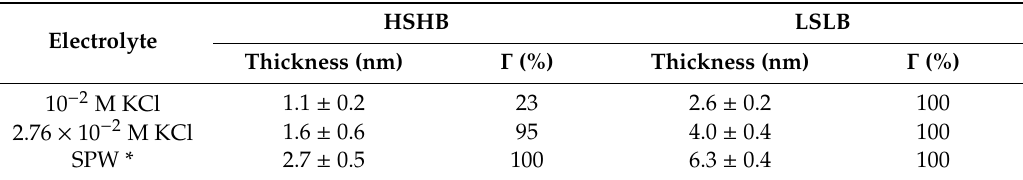
Table 2. Thickness and surface coverage ( Γ ) of adsorbed CMC (5 mg/L) at pH 9 on molybdenite (reprinted with permission from Kor et al. [35], copyright (2014) American Chemical Society). HSHB, high substitution, high blockiness; LSLB, low substitution, low blockiness; SPW, simulated process water.